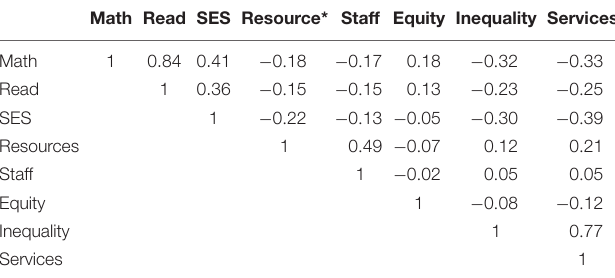
TABLE 1 | Mean, standard deviation, minimum, and maximum values for variables used in the models.